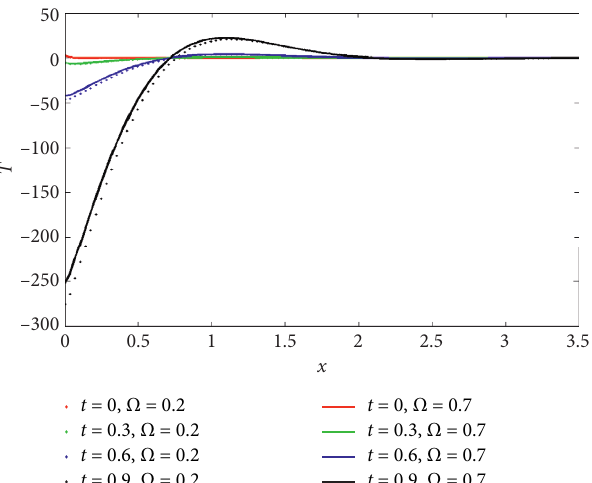
Figure 27: Vertical displacement w concerning x with magnetic and rotation.